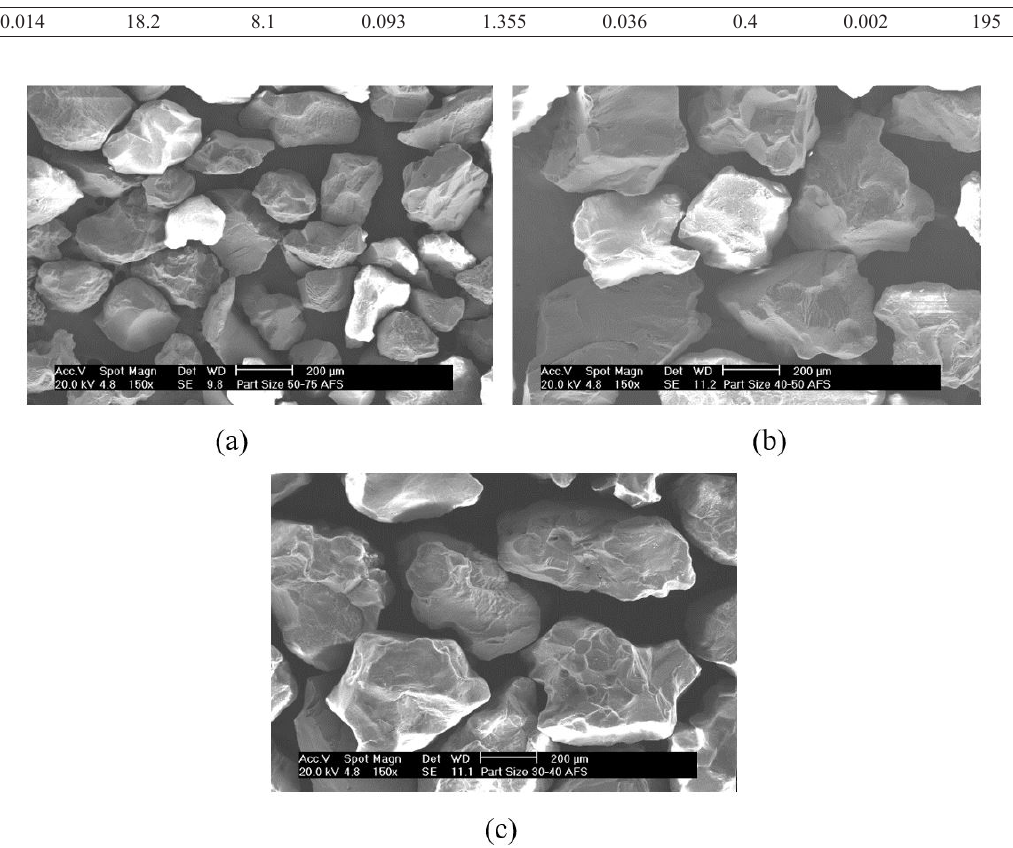
Figure 2. SiO particles used in the corrosion-erosion test. Three different sizes where used: (a) 50-75 AFS (200 - 300 μm), (b) 40-50 AFS, 2 (300 - 420 μm) and (c) 35-40 AFS, ( 420 and 500 μm).